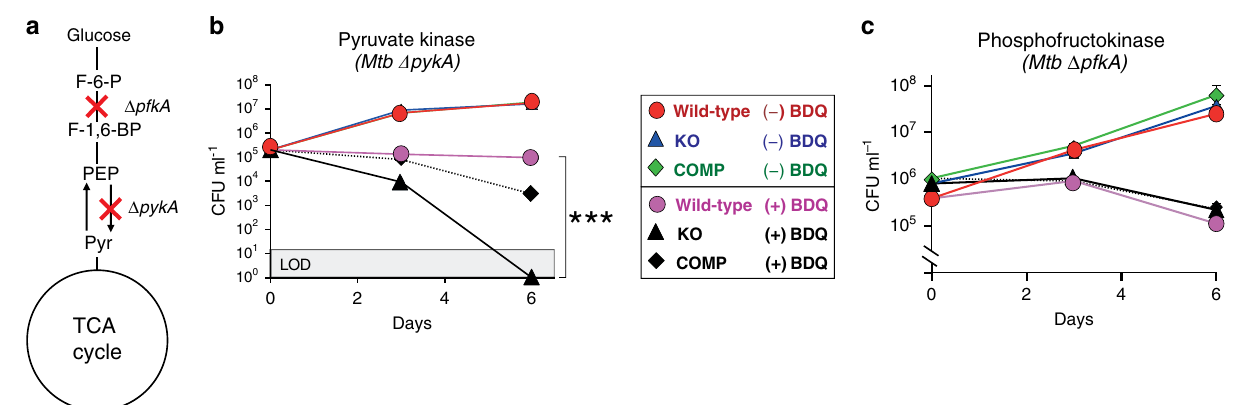
Fig. 8 Disruption of distinct steps in glycolysis/gluconeogenesis synergises with BDQ. a Diagram illustrating disruption of glycolysis. b Kill curves for Mtb Δ pykA , and ( c ) Mtb Δ pfkA were generated from CFUs measured after 6 days of culturing. Limit of detection (LOD) is 10 CFU per ml − 1 . Two separate, independent kill curve experiments were performed with representative data shown. A one-way ANOVA and Tukey multiple-comparison test were used for the statistical analysis. Mean + / − standard error of the mean (SEM) of at least three replicate CFU plates is indicated for each point. n = 3 biologically independent replicates. F-6-P - fructose-6 phosphate, F1,6-BP - fructose-1,6-bisphosphate, PEP - phosphoenolpyruvate, Pyr - pyruvate, BDQ - bedaquiline, COMP - complement strain. *** P <